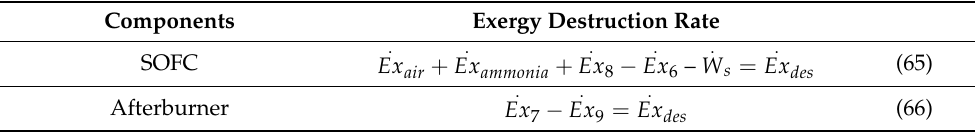
Table 4. Exergy destruction equations of the main